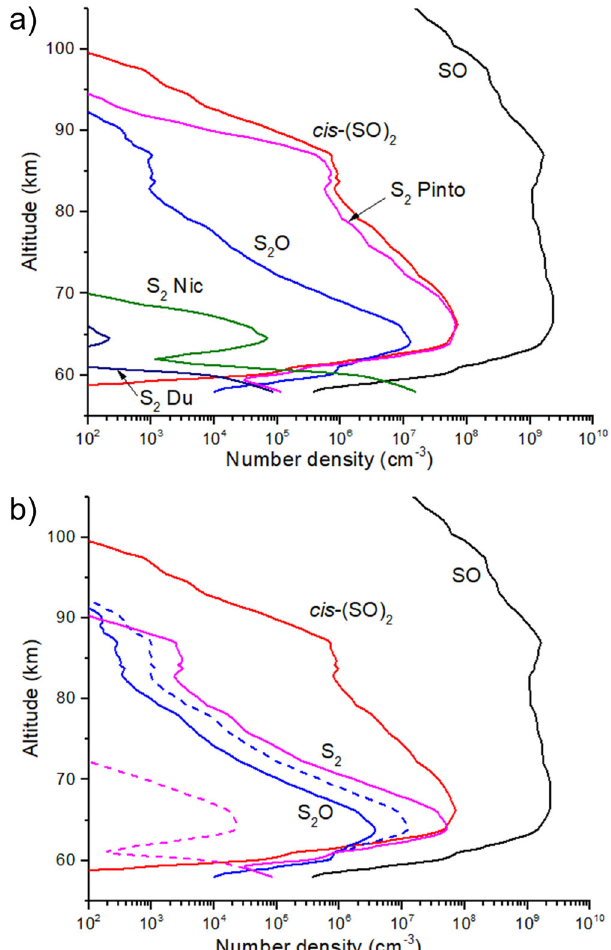
Fig.3|Estimatedsteady-statepro fi lesforseveralkeysulfurspecies.a S 2 pro fi les for several possible model conditions. “ S 2 Pinto ” is derived from photolysis of cis - OSSO as in Pinto et al. 19 . Turning off this reaction and using a fast 3 S+ 3 S rate coef fi cient 79 yields “ S 2 Nic ” , and using a slower 3 S+ 3 S rate coef fi cient 80 yields “ S 2 Du ” . In both cases 3 S 2 is dramatically reduced. b With the Pinto et al. S 2 formation mechanism turned off, reaction of 3 SO with 1 S 2 O becomes the dominant pathway for 3 S 2 . 3 S 2 and 1 S 2 O pro fi les are shown for a rate constant of 1×10 − 10 cm 3 s − 1 (solid lines) and for a rate constant of 1×10 − 14 cm 3 s − 1 (dashed lines). The higher rate constant is consistent with ab initio calculations presented here and yields sub- stantial 3 S 2